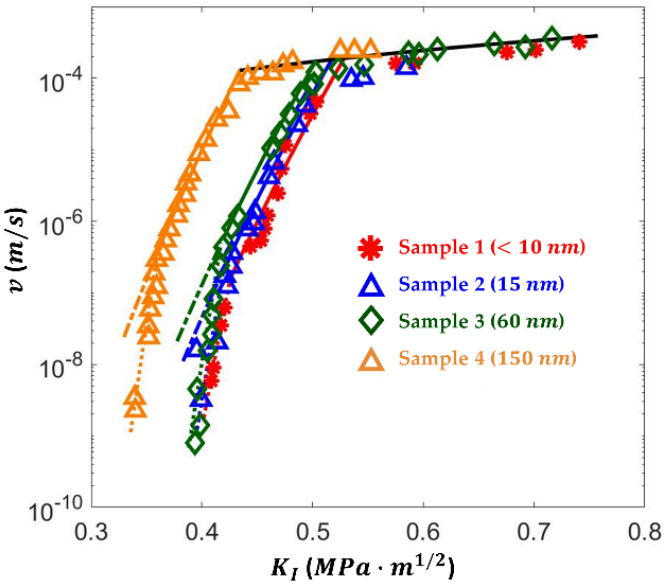
Figure 19. Crack growth data for SBN glass with chemical composition: [ SiO 2 ] = 70.0 mol%, [ B ] = 23.0 mol%, and [ Na ] = 7.0 mol% after varying degrees of phase separation. Sample 1 (red stars) annealed at 550 ◦ C for 6.5 h, phase size < 10 nm; Sample 2 (blue triangles) annealed at 620 ◦ C for 0.5 h, phase size ∼ 15 nm; Sample 3 (green diamonds) annealed at 620 ◦ C for about 35 h, phase size ∼ 60 nm; and Sample 4 (yellow triangles) annealed at 650 ◦ C for about 90 h, phase size ∼ 150 nm. Recreated from [146] with permission from Elsevier; published by Simmons et al.,